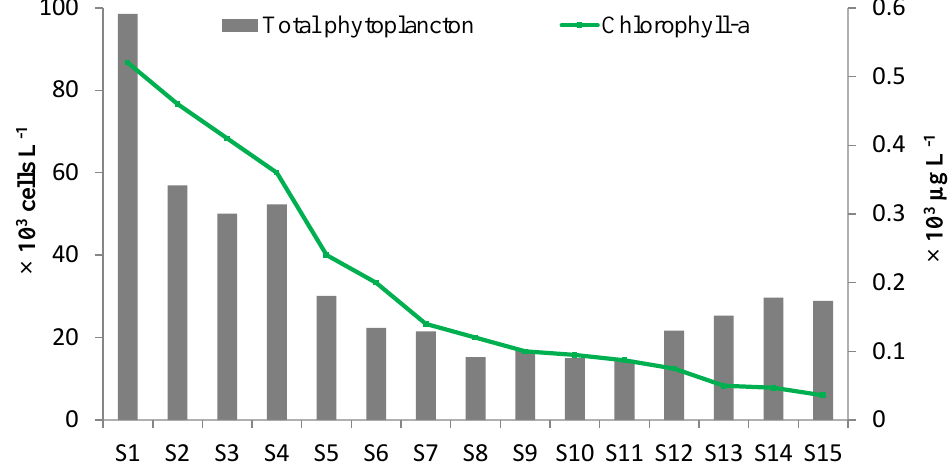
Values in each line that share the same letter are not significantly different ( p > 0.05). Asterisks de- note significant differences between different sampled transects: * p < 0.05; ** p < 0.01; *** p < 0.001.